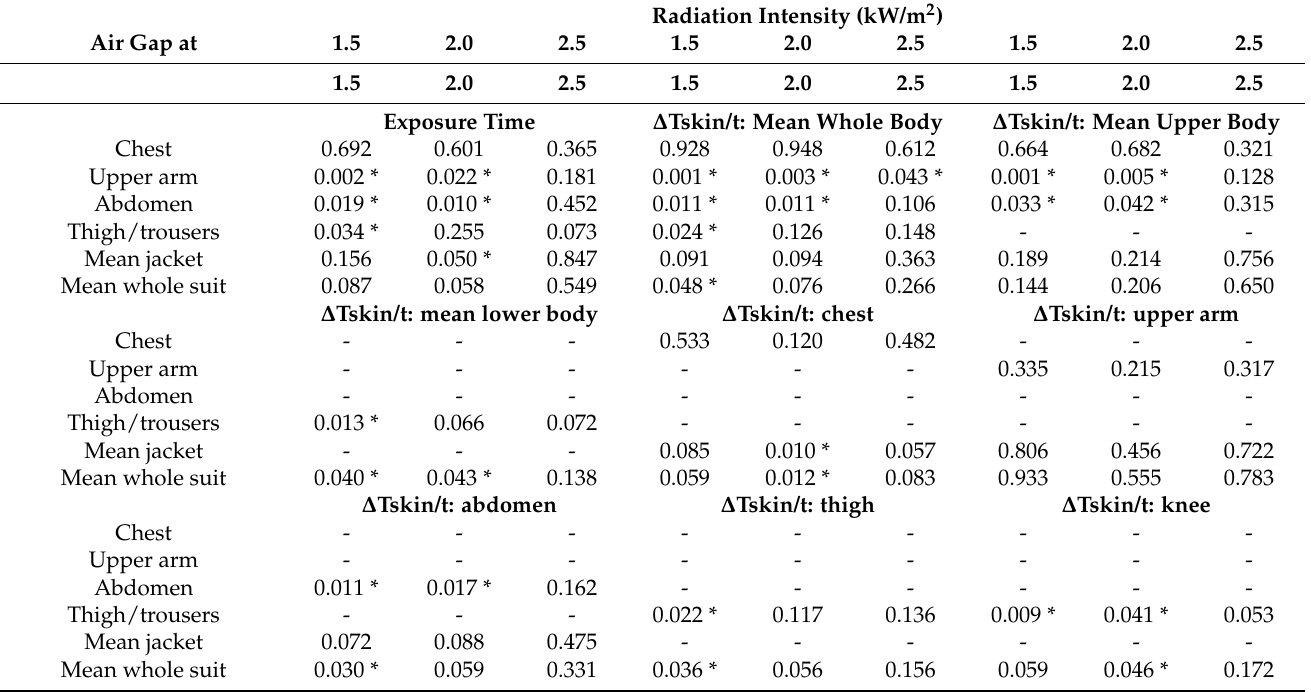
Table 8. Simple linear regression outcomes, p -values. Different air gaps as the independent variable and exposure time or body location specific ∆ Tskin/t as the dependent variable. Regressions were made for all three different radiation